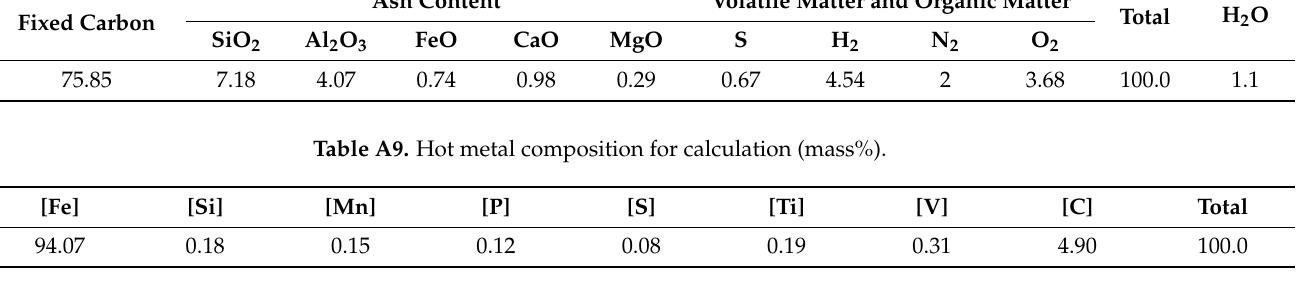
Table A10. Slag composition for calculation (mass%).